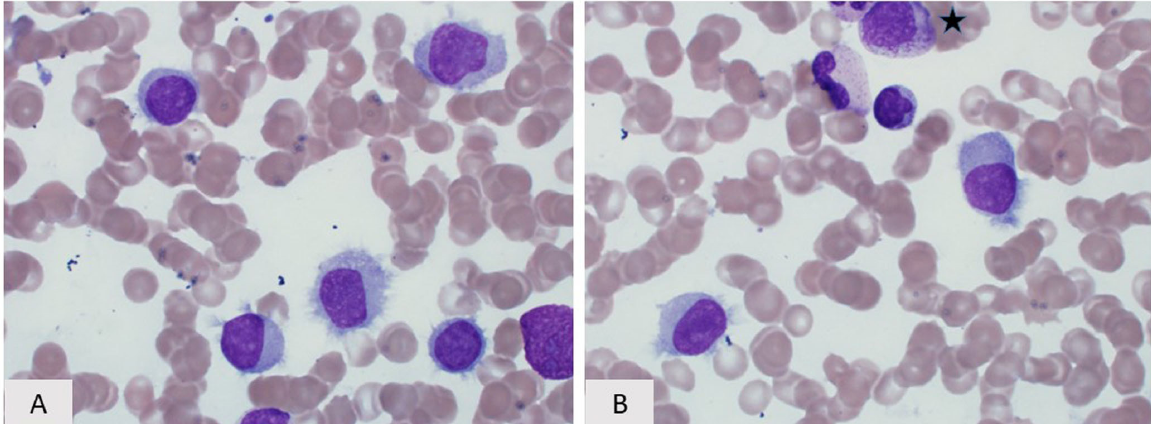
Figure 4. Hairy cell leukemia variant. ( A ) Peripheral blood smear and ( B ) bone marrow aspirate, (a myelocyte is present in the top of the field ★ ), Wright–Giemsa, 400×. The cytologic features range from typical “hairy cells” showing prominent circumferential cytoplasmic projections, rounded nuclei, spongy chromatin, and inconspicuous/absent nucleoli to cells with less prominent cytoplasmic projections, more finely dispersed chromatin m, and occasional prominent nucleoli.